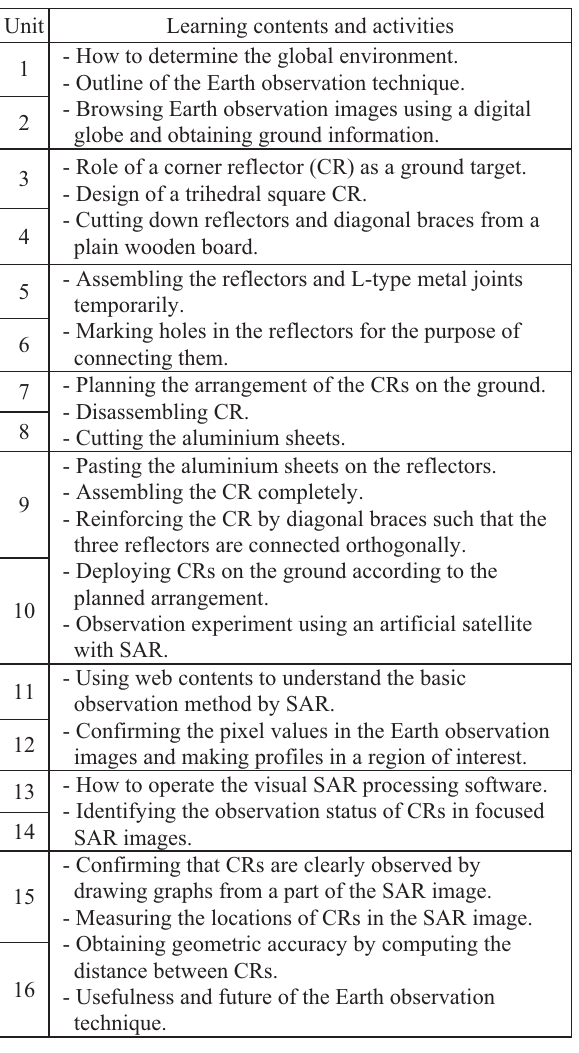
Table 1. Teaching program with Earth observation technique.